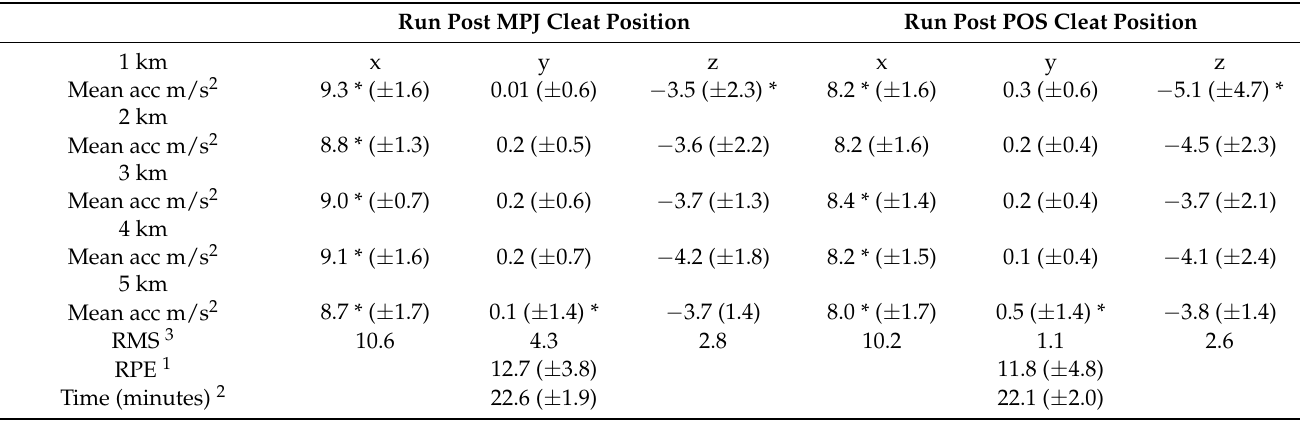
Table 5. Descriptive data (means ± SD) from individual 5 km run post cycling in two cleat positions (in m/s 2 ). 1 RPE = ratings of perceived exertion. ² Time in minutes = mean time for completion of 5 km run. 3 RMS = root mean square.